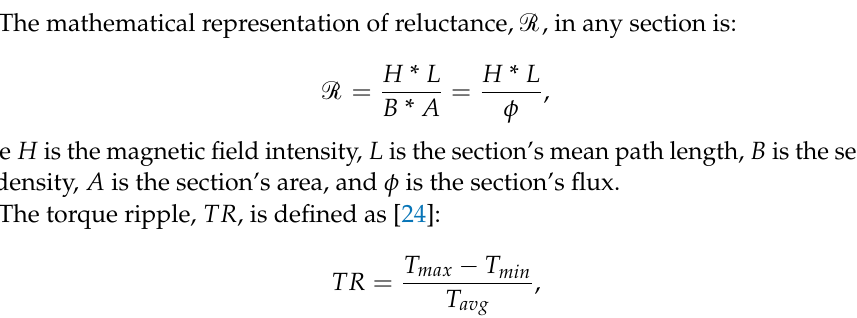
Figure 3. SRM’s magnetic circuit showing the interconnection of circuit